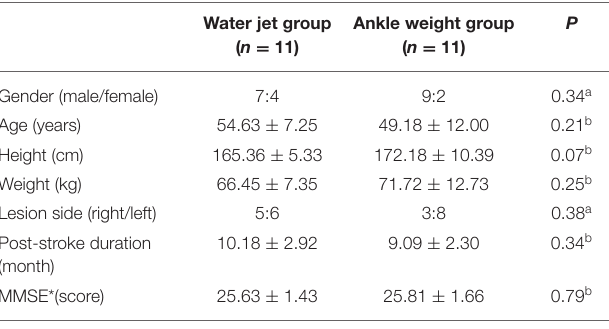
TABLE 1 | General characteristics of the two groups by randomization assignment.